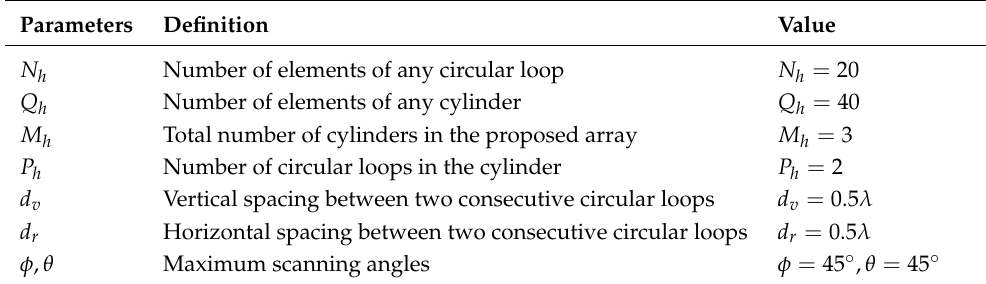
Figure 1. A demonstration of the 3D configuration of the hybrid antenna array with bowtie elements at the frequency of the operation of 10 GHz with bowtie elements. ( a ) The assigned design parameters of the hybrid antenna array are listed in detail in Table 1. In this work, each hybrid antenna array consists of three cylindrical antenna arrays [15], and one circular antenna array [16], and ( b ) a top view of the bowtie antenna; l : arm length, α : flare angle, g : feed gap, w : bar width, b : bar length. In this work, the design parameters of each bowtie element are assumed to be l = 6 mm, α = 60 ◦ , g = 0.02 mm, w = 0.02 mm, and its thickness is equal to 0.01 mm [7]. Table 1. The design parameters for the proposed hybrid antenna array of Figure